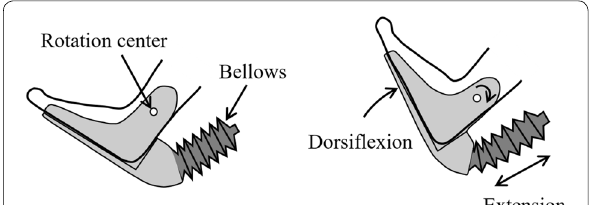
Fig. 1 Operational principles. Left: Initial stage. Right: Pressurization causes bellows to extend longitudinally, leading the machine’s moving part to rotate around the rotation center (Adapted from